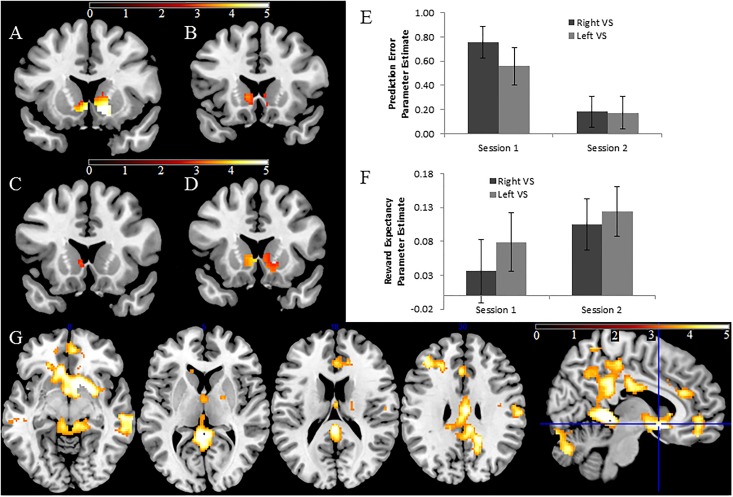
Significant VS PE-related activity was observed at time 1 (A) but not time 2 (B).Significant VS RE-related activation was observed at time 2 (C) but not time 1 (D). Figures thresholded at p<0.025 uncorrected, and masked with the ROI, for display purposes. Bar charts of extracted parameter estimates, displaying the mean PE-related (E) and RE-related (F) findings within the entire VS regions of interest. Error bars reflect standard errors of the mean (SEM). (G). Whole brain PE activations at time 1, thresholded at p<0.001, k>200.